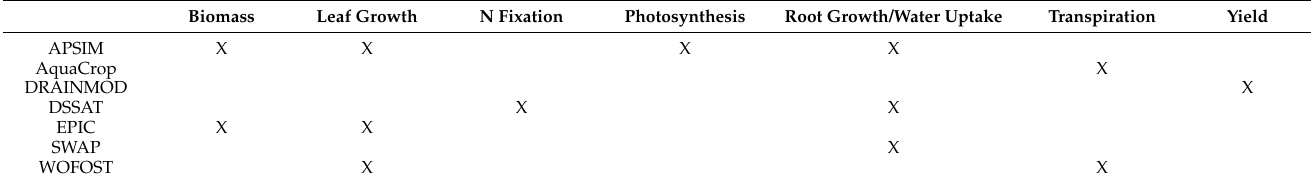
Table 2. Crop growth variables and processes explicitly impacted by waterlogging in the crop models reviewed